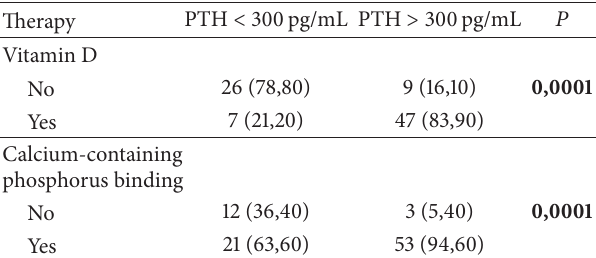
Table 2: The treatment received according to serum levels of parathormone.